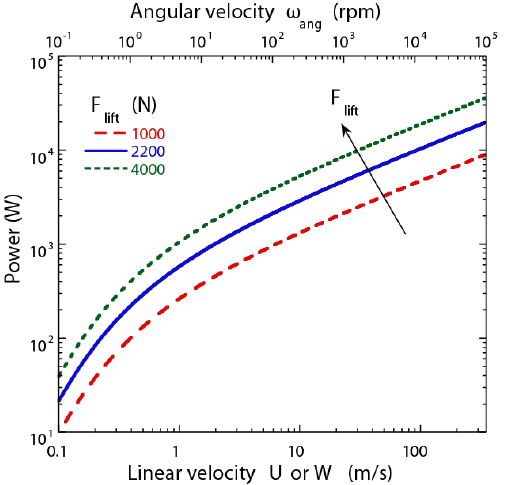
Figure 11. Power requirement for three different Hyperloop pod weights; Bottom abscissa: Linear velocity U of passive, or W of active maglev; the plot also presents battery power requirement of active maglev as a function of its angular velocity ω ang (top abscissa). Power scales linearly with weight.